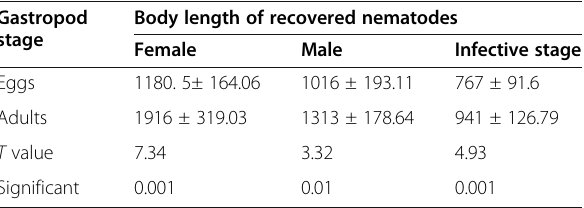
Table 2 Size in micrometer of nematodes recovering from eggs and adult of some